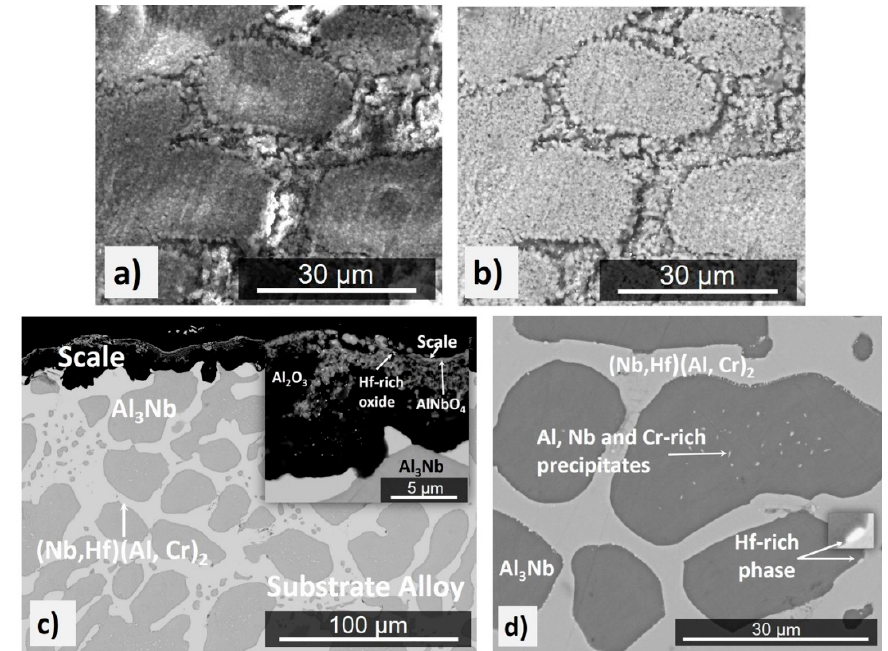
Figure 9. The scale and microstructure of the alloy OHC3 after isothermal oxidation at 1200 °C for 80 h. (a) and (b) images of the surface of the scale (a) SE, X4000, (b) BSE, X4000. (c) and (d) BSE images of cross-sections, (c) shows the scale composed of two species, X1000, insert X8000 (b) the microstructure of the substrate, X4000.